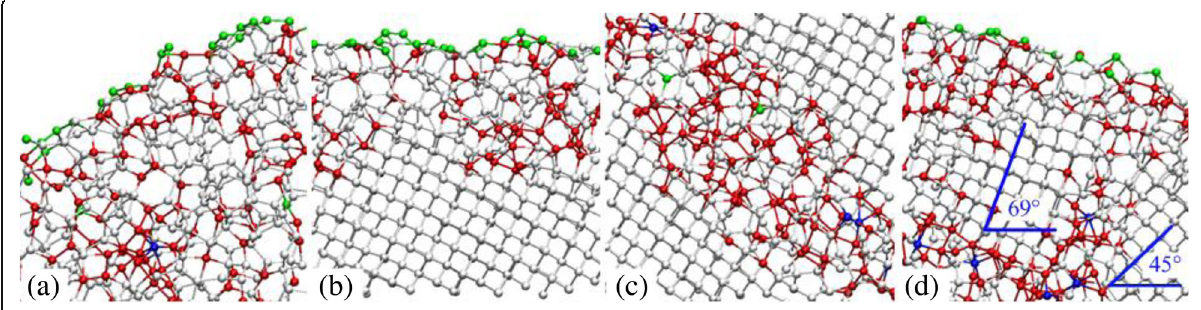
Fig. 3 Enlarged views of a A zone, b B zone, c C zone, and d D zone in Fig. 2